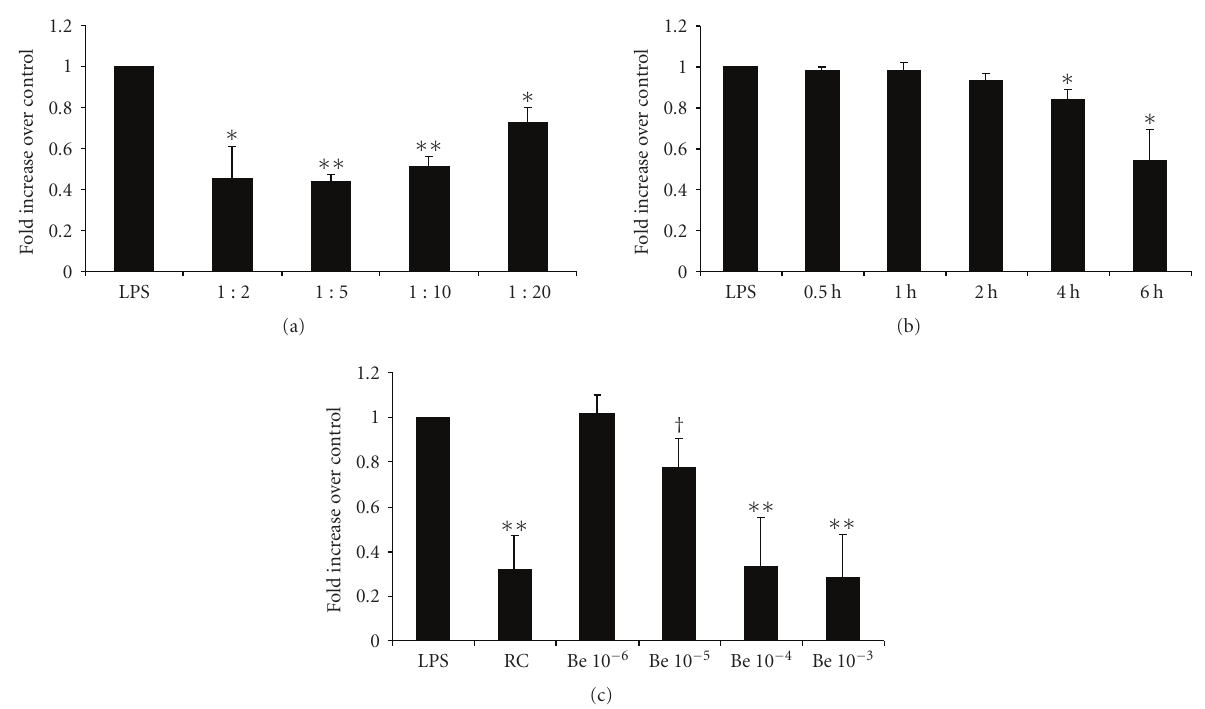
Figure 6: Secrection of MCP-1/CCL2 was evaluated with ELISAs of supernatants. Supernatants were collected after preincubation with di ff erent concentrations (a) and exposure times (b) of Rhizoma coptidis. Berberine also inhibited MCP-1/CCL2 secretion in a concentration- dependent fashion (c). Berberine concentrations listed represent mol. LPS: lipopolysaccharide, RC:Rhizoma coptidis , Be: berberine, MCP- 1/CCL2: monocyte chemoattractant protein-1. ∗ P < . 005, ∗∗ P < . 001. AP-1: activated protein-1, Co: LPS-stimulated control cells, and CC: cold competition. † P < . 05, ∗ P < . 005, ∗∗ P < .